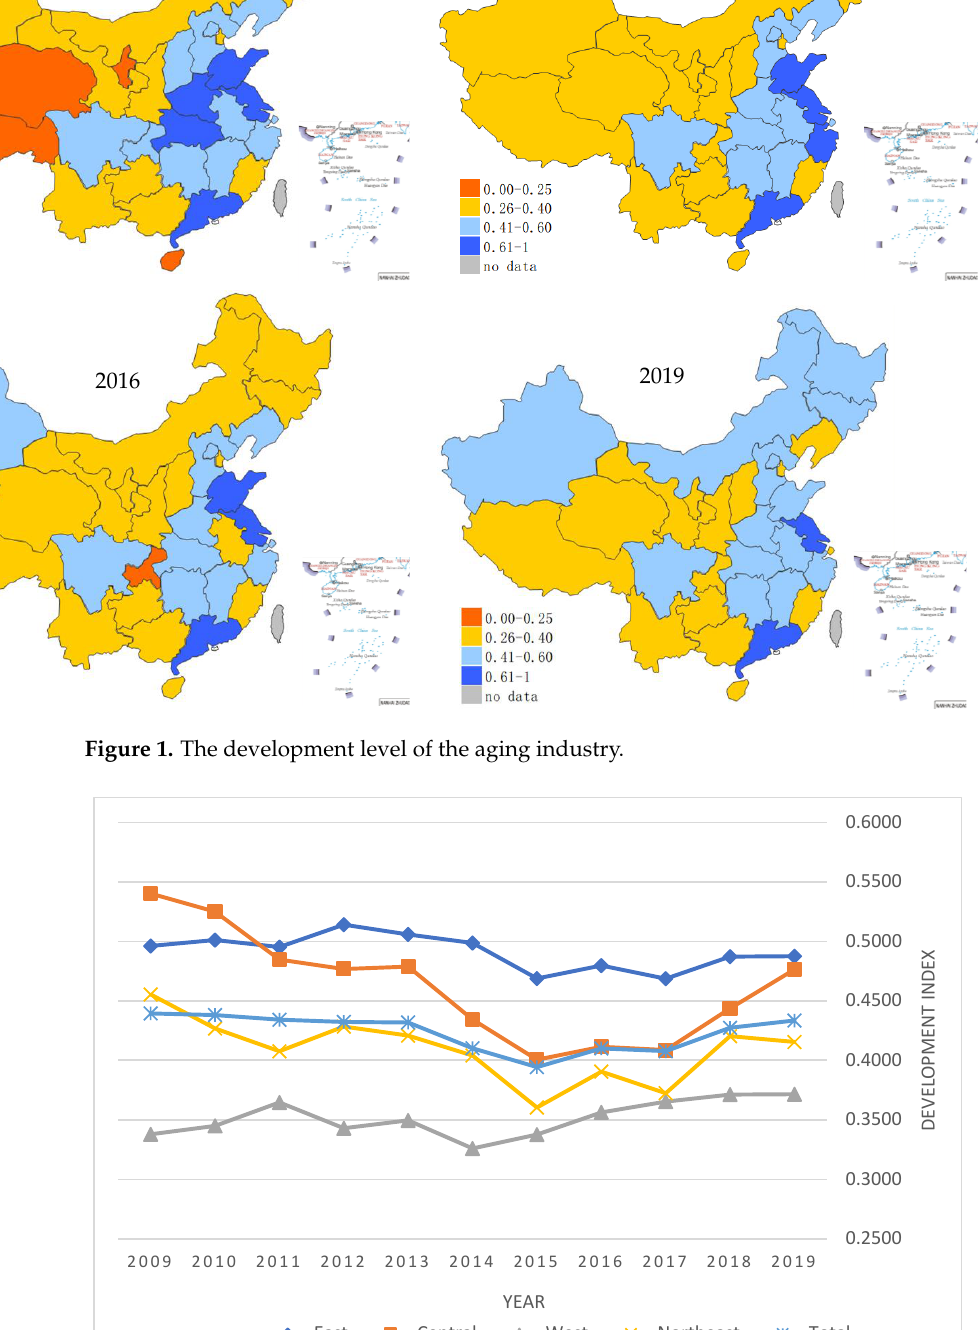
Figure 2. Sub-regional development index of the aging industry. 4.1.2. Space-Time Evolution of Regional Economy Development